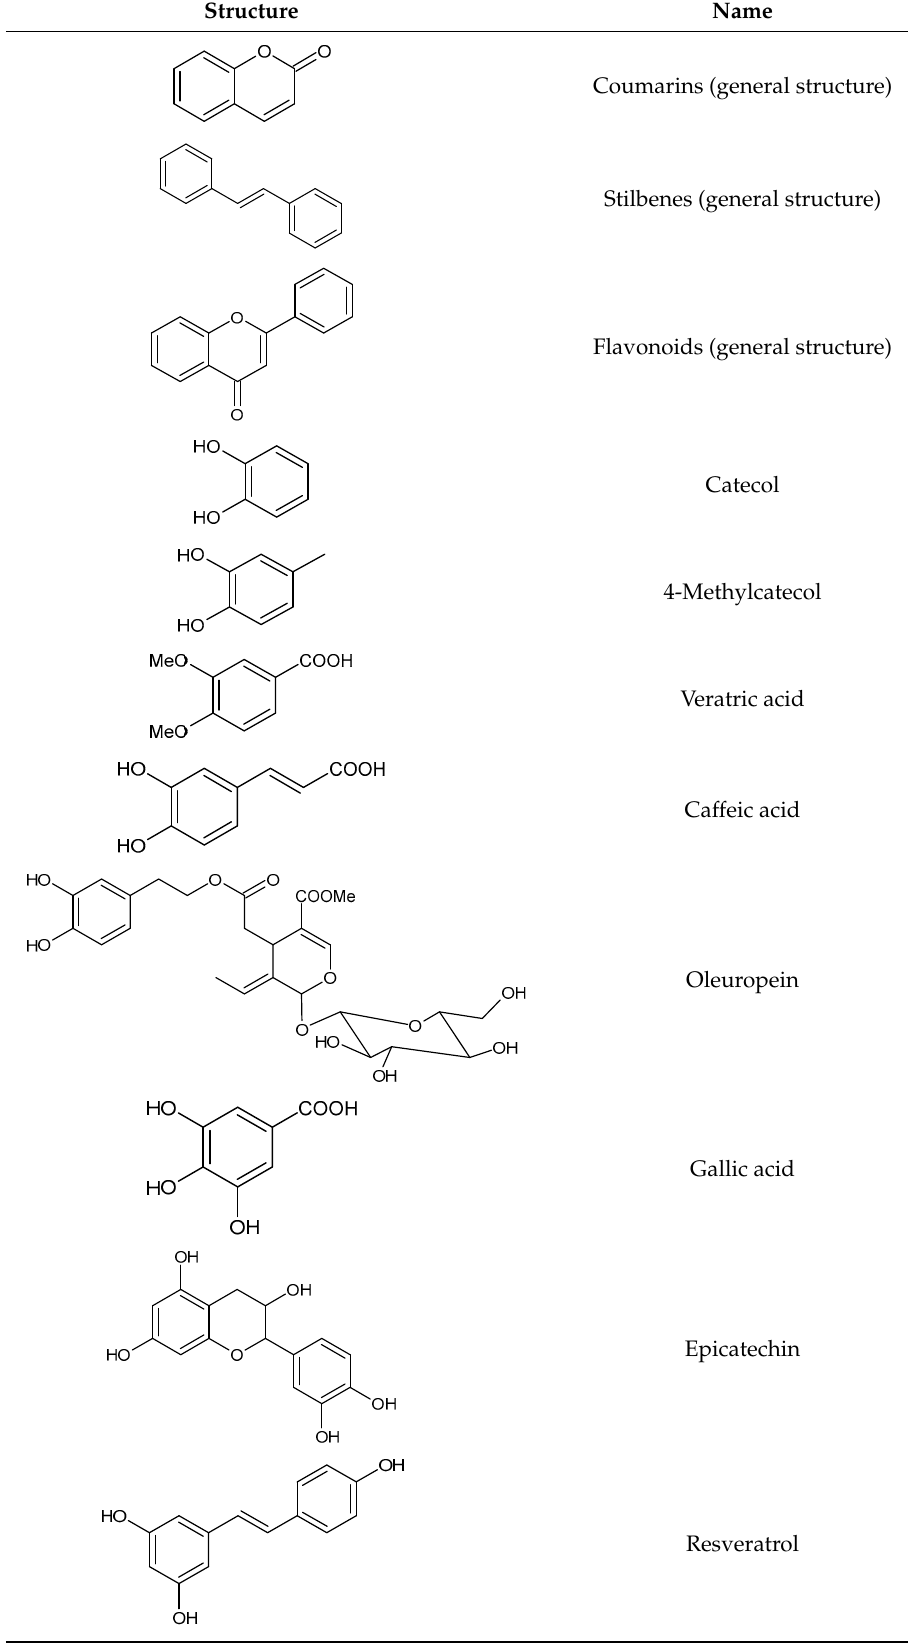
Table 1. Structure of compounds described in the text.